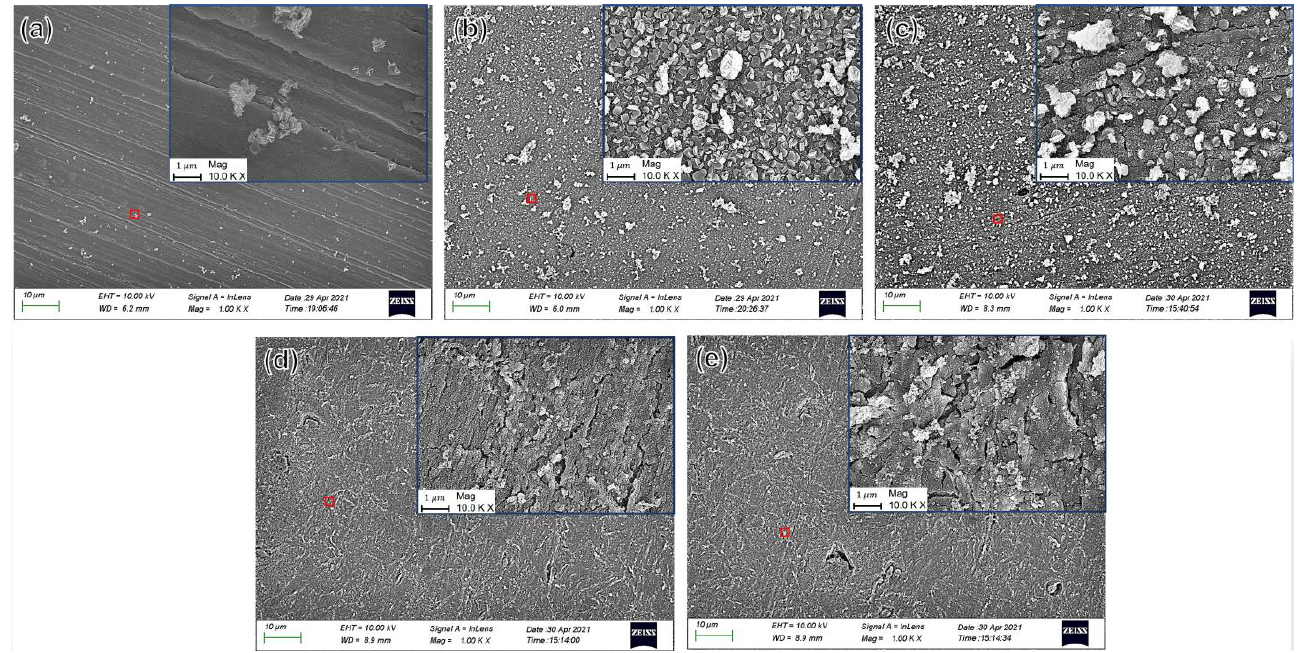
Figure 9. SEM corrosion product images of X80 steel samples after 2 h in NS4 solution under various DC densities without strain: ( a ) i DC = 0 mA/cm 2 , ( b ) i DC = 0.25 mA/cm 2 , ( c ) i DC = 0.5 mA/cm 2 , ( d ) i DC = 1 mA/cm 2 , ( e ) i DC = 2 mA/cm 2 .